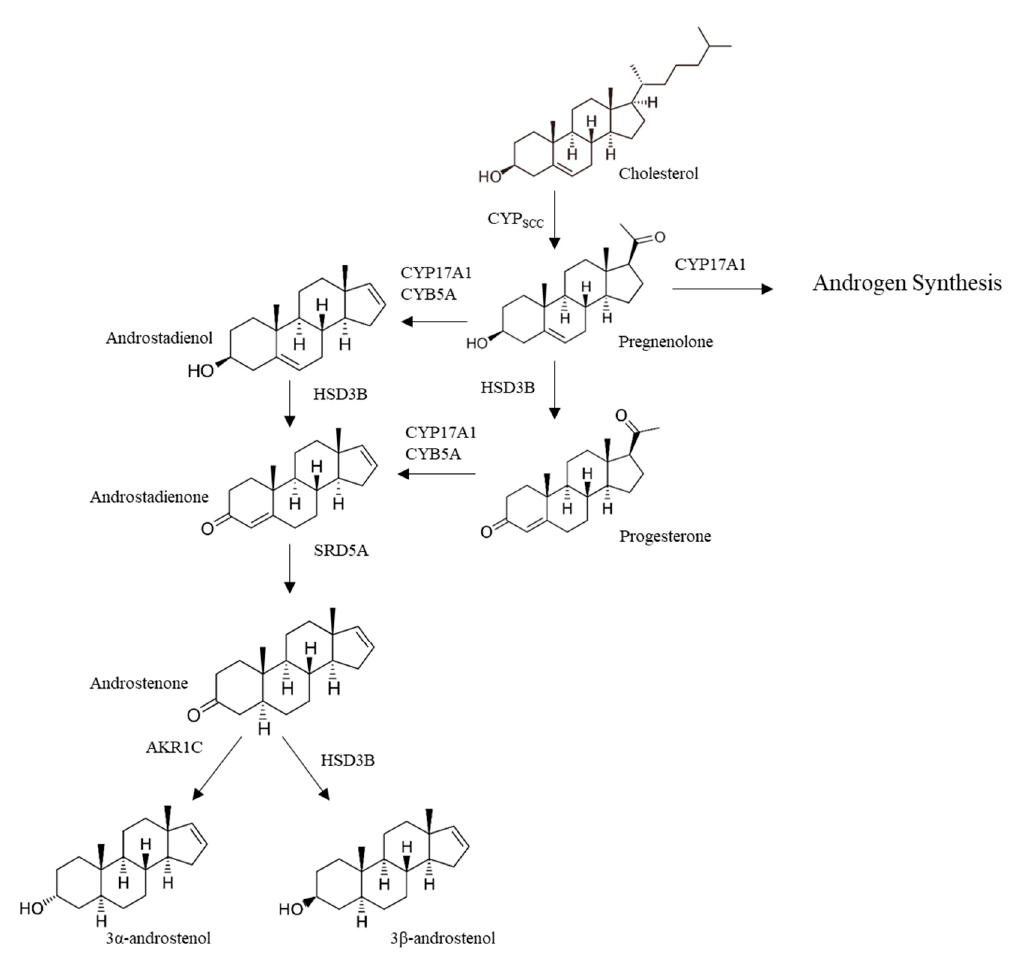
Figure 2. Pathways of androstenone synthesis and metabolism.